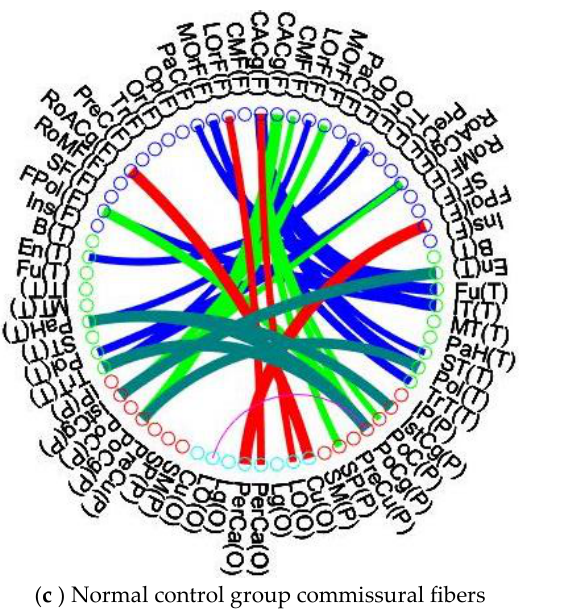
Figure 5. Long lateral hemisphere connections and bilateral hemisphere connections between lobes of the control and MCI groups: ( a ) Control group long lateral hemisphere connections; ( b ) MCI group long lateral hemisphere connections; ( c ) control group bilateral hemispheres connections; ( d ) MCI group bilateral hemispheres connections. In each figure, the left half depicts the left hemisphere, while the right half depicts the right hemisphere. In each hemisphere, there are four lobes, labeled frontal, temporal, parietal, and occipital. Each ROI of the frontal lobe is labeled with a blue circle and abbreviation, the temporal lobe is indicated with a green circle, the parietal lobe with a red circle, and the occipital lobe is illustrated with a green-blue circle. As revealed in the intra-lobular connectivity analysis, the width of the connecting lines in each figure indicates the strength of the connectivity coefficient between nodes, with wider lines implying higher connectivity between nodes. In Figure 5, we use the color of the lines to indicate the different connecting links between the brain lobes. Blue lines indicate links from frontal to temporal lobes, frontal to parietal connections are represented by yellow-green lines, and links from frontal to orbital lobes are represented by red lines. Yellow lines indicate links from the temporal lobe to the occipital lobe, connections between the temporal and parietal lobes are represented by mossy green lines, and purple lines indicate connections between the occipital and parietal lobes.